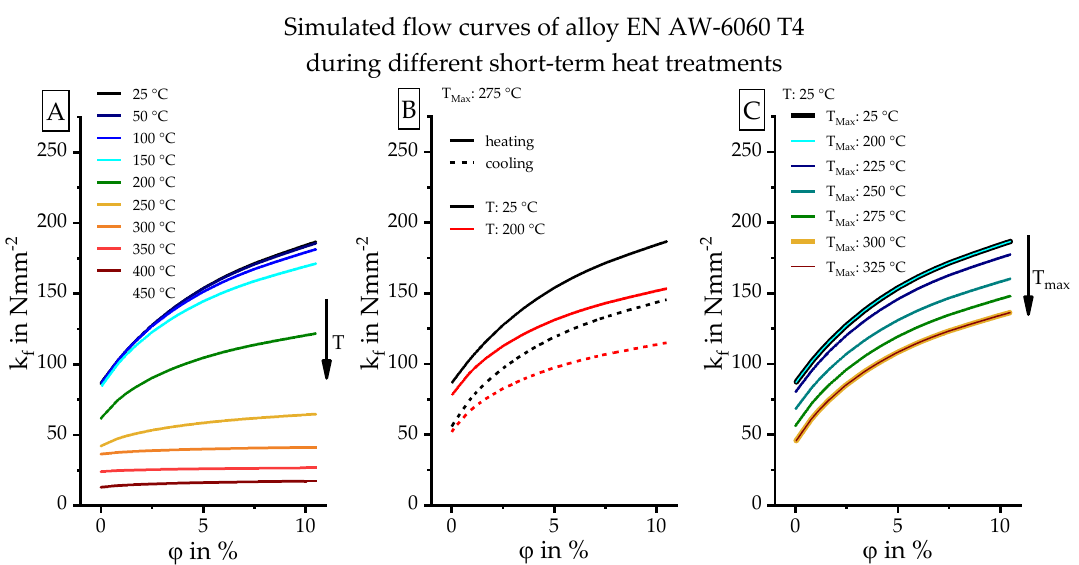
Figure 20. Simulated flow curves of alloy EN AW-6060 T4 during various short-time heat treatments. ( A ) During heating to different temperatures; ( B ) Distinction heating/cooling to 25 °C and 200 °C after T Max : 275 °C; ( C ) At 25 °C according to different maximum temperatures.